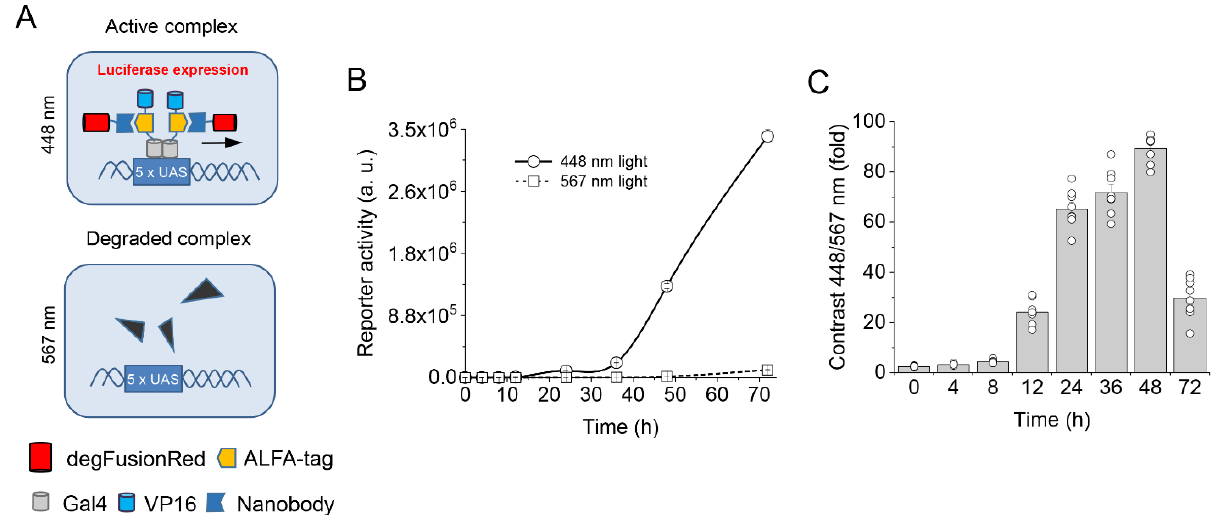
Figure 5. Light-dependent degradation of protein of interest by degFusionRed. ( A ) A model protein of interest (Gal4-ALFA-tag-VP16) targeted by anti-ALFA-tag nanobody fusion with degFusionRed (Nb ALFA -degFusionRed) to form a complex. Under 448 nm light (top), the formed transcription complex binds 5 × UAS, resulting in the transcription of the luciferase reporter. Under 567 nm light (bottom), the Gal4-ALFA-tag-VP16 transcription factor is degraded together with the bound Nb ALFA - degFusionRed. ( B ) Kinetics of luciferase expression in HEK293 cells under 448 nm and 567 nm illumination from the beginning of transfection to 72 h of the experiment. ( C ) The difference in the luciferase expression between 448 nm and 567 nm illuminated cells measured in panel ( B ) results in large contrast values, reaching its maximum at 48 h after cell transfection.